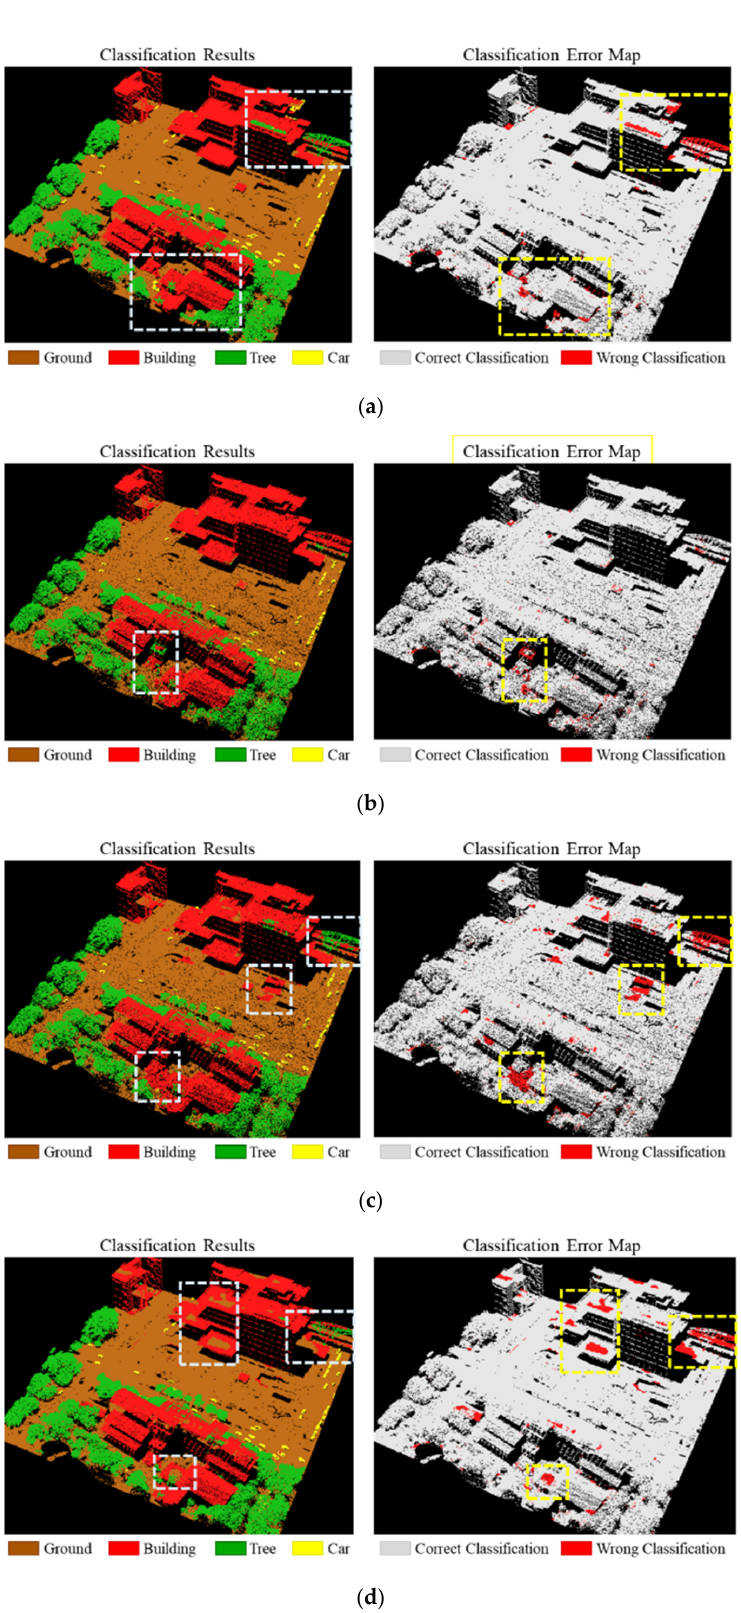
Figure 17. Classification results of RF and DL models on ALS point cloud with four classes: ( a ) Classification results of RF; ( b ) Classification results of PointNet(F); ( c ) Classification results of PointNet ++ ; ( d ) Classification results of